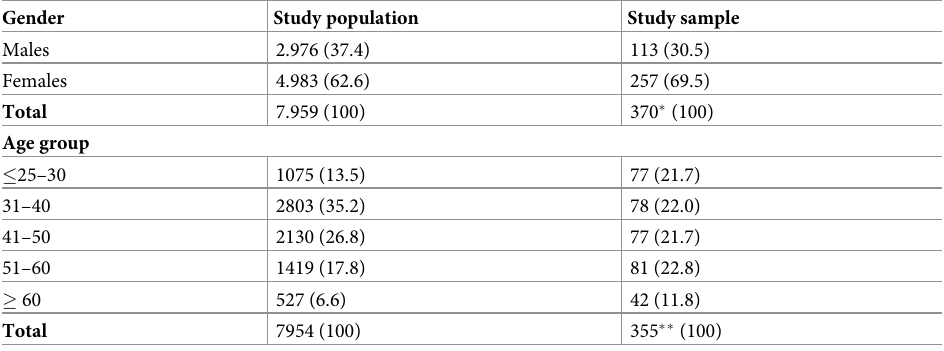
Table 2. Analysis of non-response regarding age groups and gender in UK (counts (percentage)).